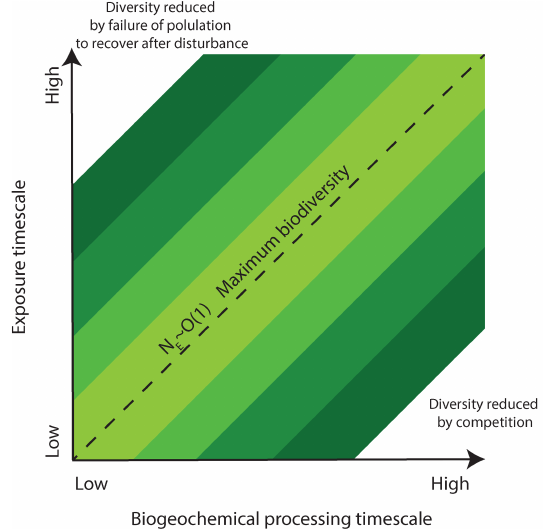
Fig. 6. The relationship between N E and biodiversity. This is likely to hold true for microbial diversity as well as landscape-scale bio- diversity. Modified from Huston